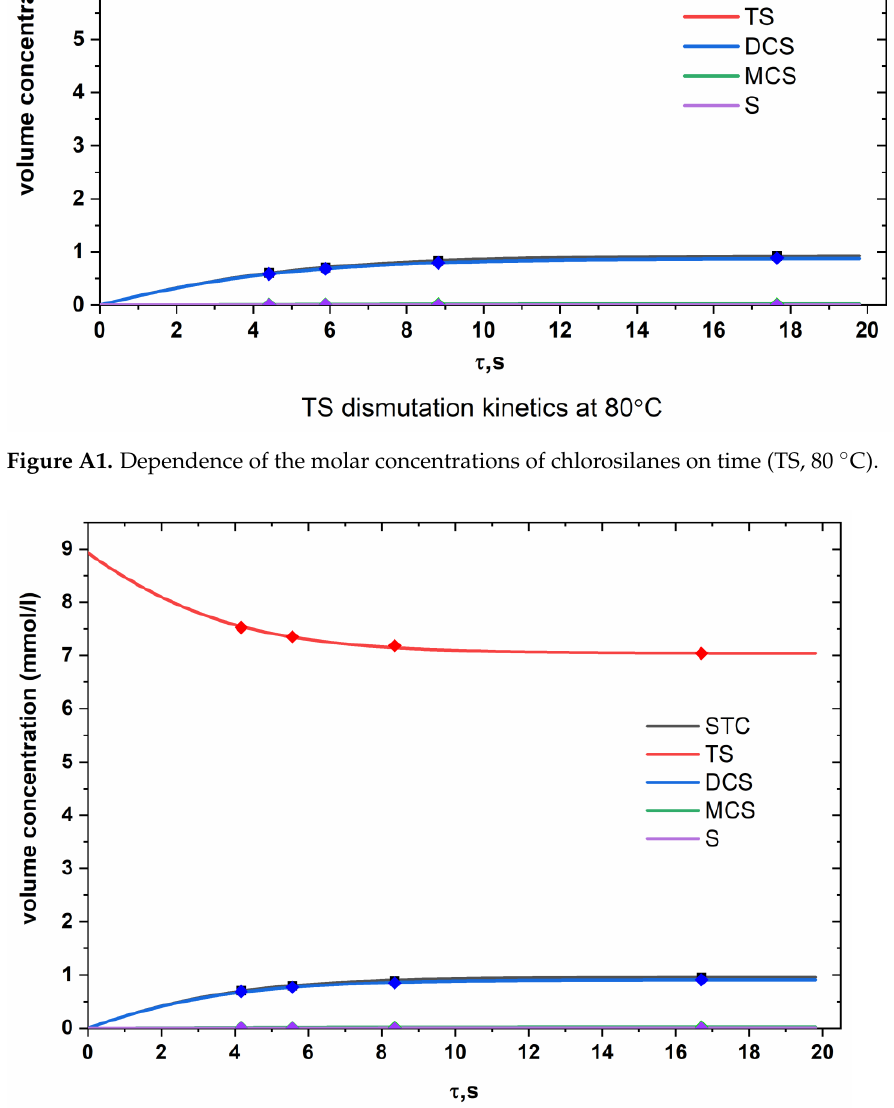
Figure A3. Dependence of the molar concentrations of chlorosilanes on time (TS, 120 °C).